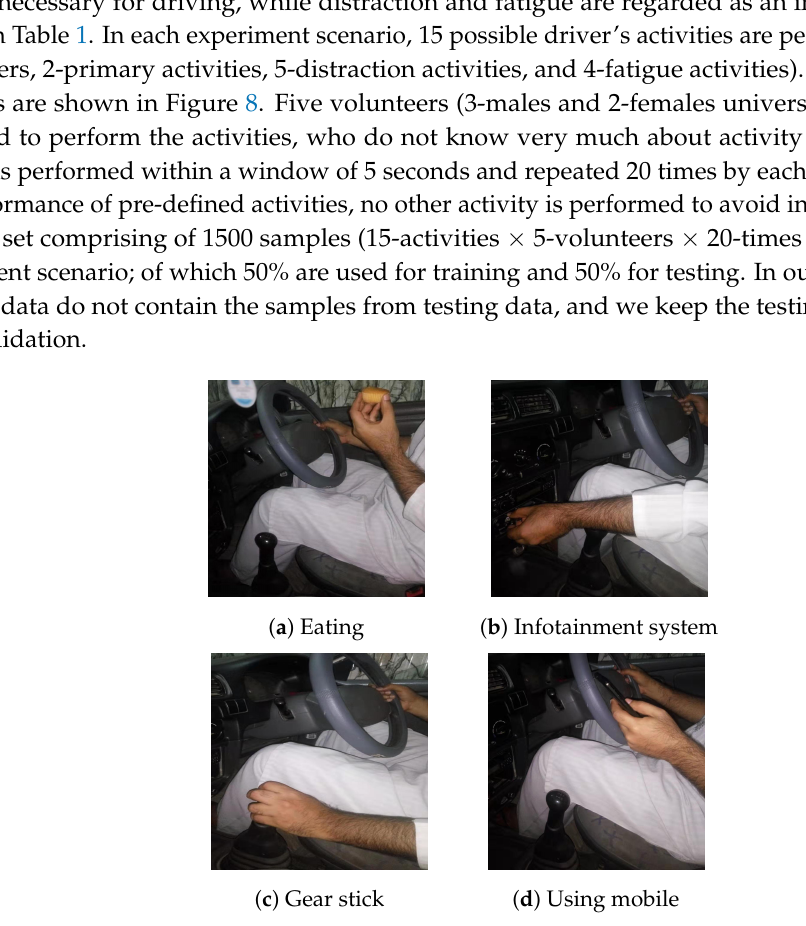
Figure 8. Activities